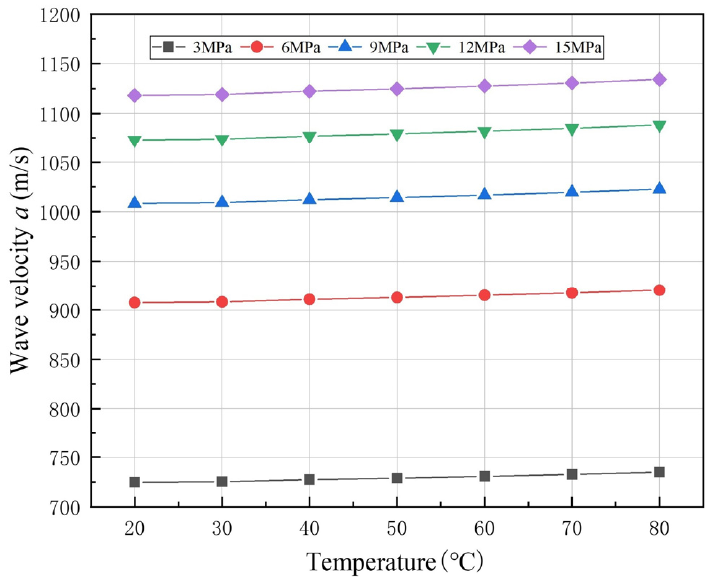
Figure 3. The effect of fluid temperature and pressure on wave velocity.